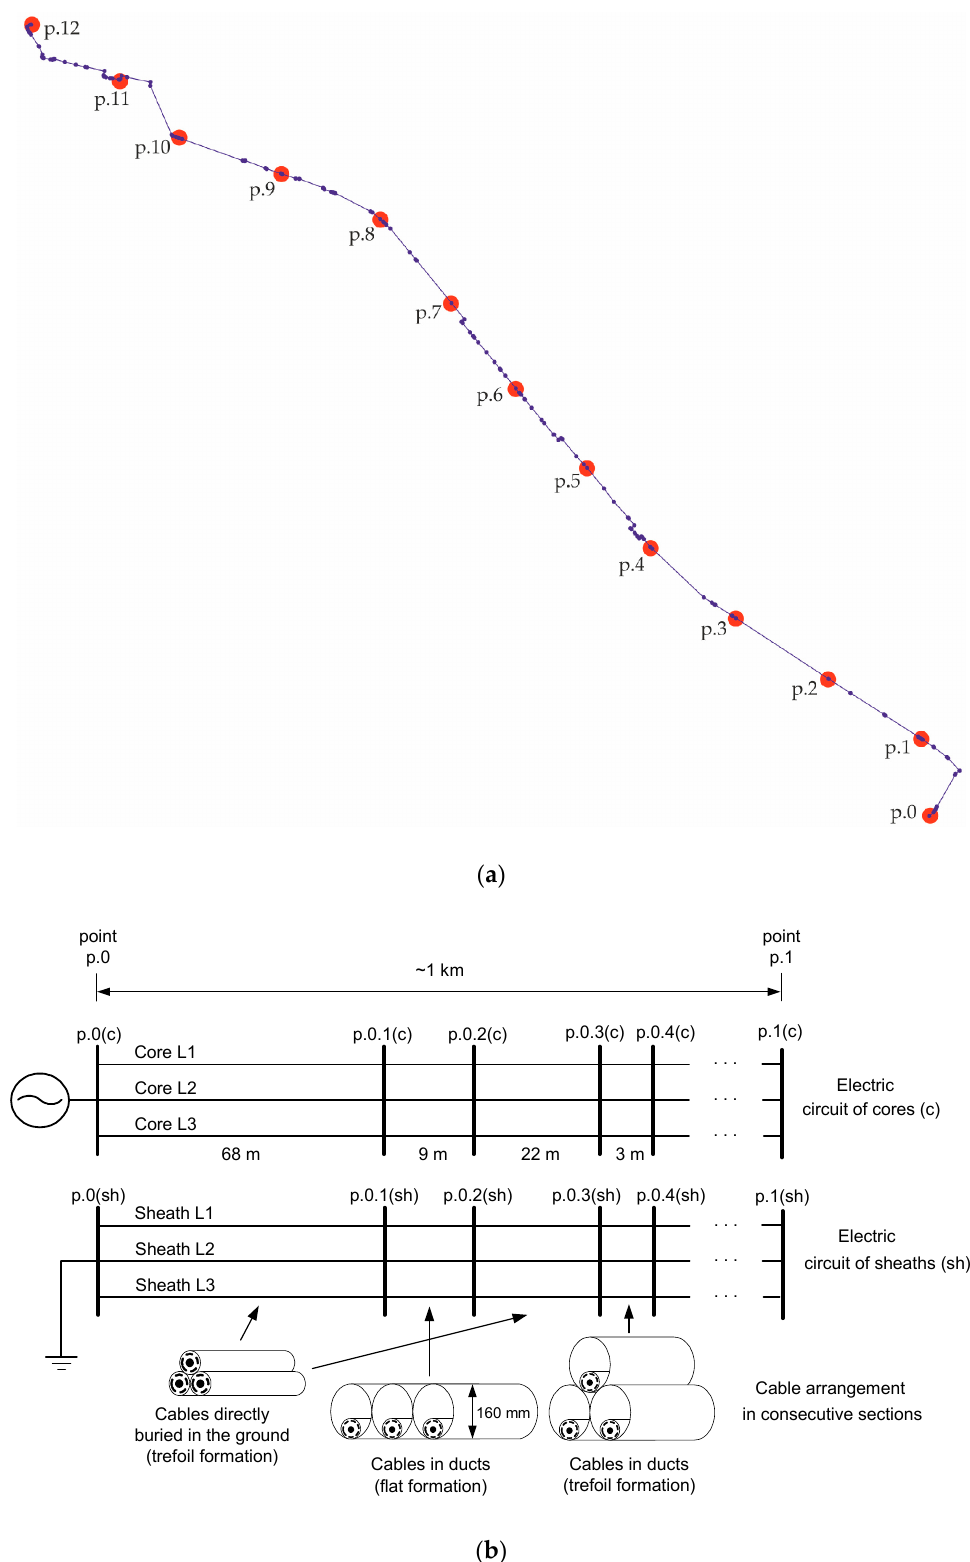
Figure 4. Real cable route of the analyzed cable system reflected in the PowerFactory software ( a ); an example part of the computer model of the cable system (minor section between point p.0 and point p.1) ( b ).